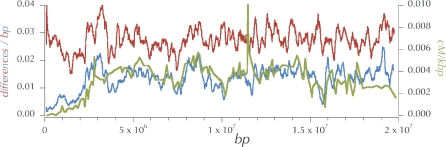
Rate of Crossing-Over per Base Pair (Green), Nucleotide Polymorphism (Blue) and Nucleotide Divergence (Red) along the X ChromosomeNucletotide π (blue) and div on the D. simulans lineage (red) in 150-kbp windows are plotted every 10 kbp. Estimated rate of crossing-over (green) is plotted for specific genomic segments (see Materials and Methods).